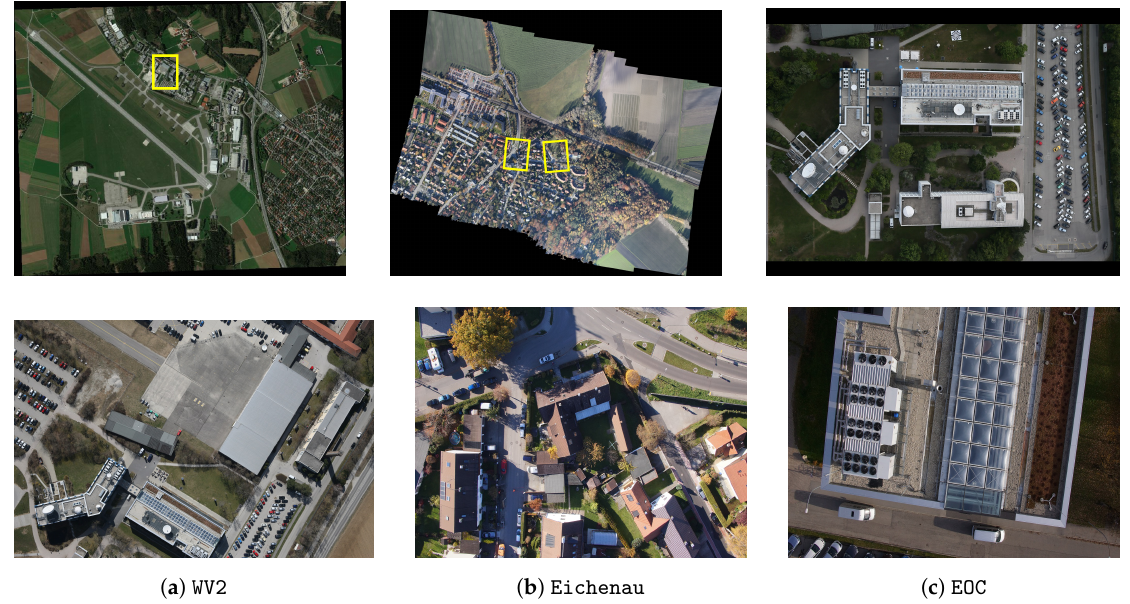
Figure 10. Additional datasets for the experiment. Top: reference images. Bottom: target images. Overlapping areas are highlighted by yellow rectangles in the reference images. ( a ) WV2 ; ( b ) Eichenau ; ( c ) EOC